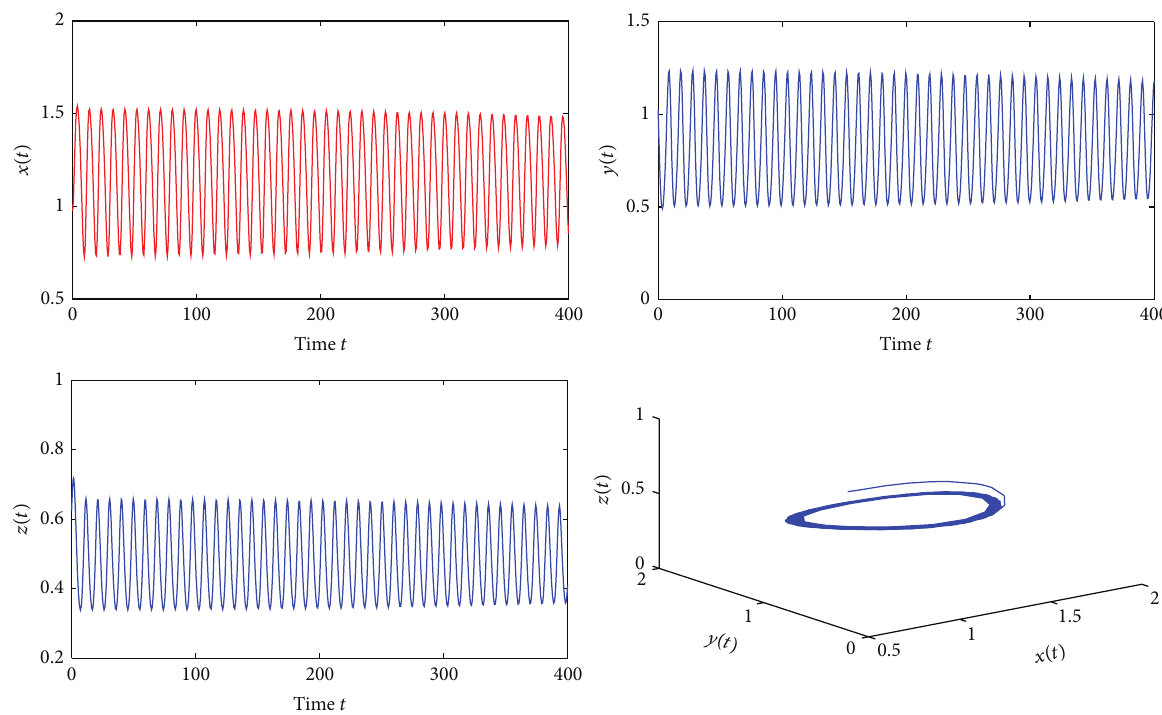
Figure 6: 𝐸 ∗ is unstable for 𝜏 1 = 0.936 > 𝜏 ∗ 1 = 0.8095 and 𝜏 2 = 0.8 with initial values 0.975, 1.025, and